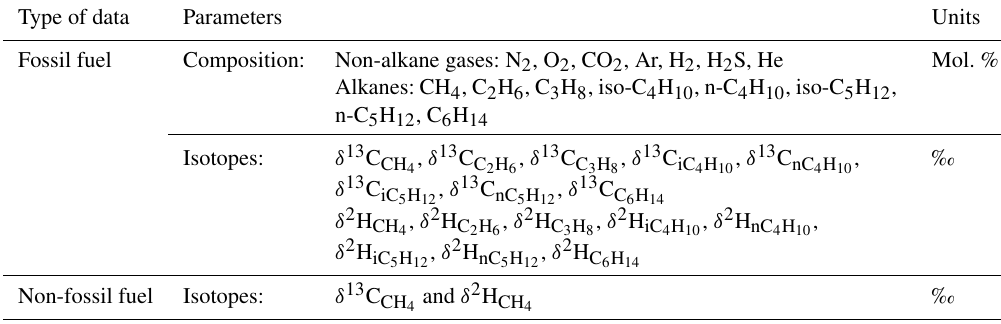
Table 2. List of geochemical parameters by gas type included in the database. Type of data Parameters Units Fossil fuel